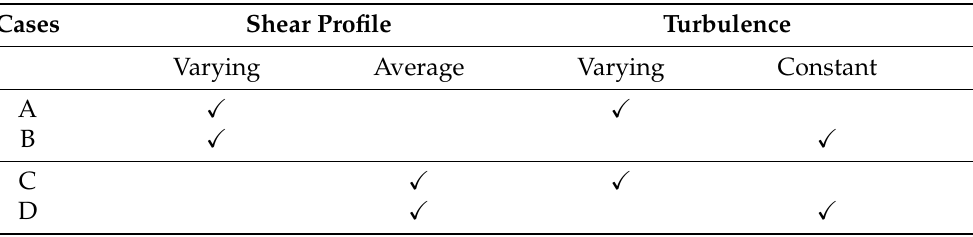
Table 2. Set up for different cases in order to examine the variation in load from each